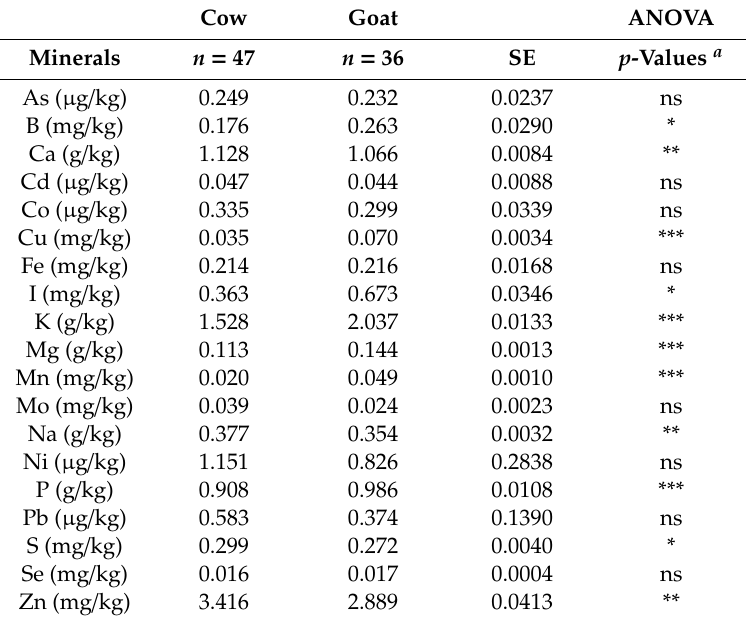
Table 3. Means (and average SE) and ANOVA p -values for the mineral concentrations of cow and goat retail milk collected throughout the study. Cow Goat ANOVA Minerals n = 47 n = 36 SE p -Values a As ( µ g / kg) 0.249